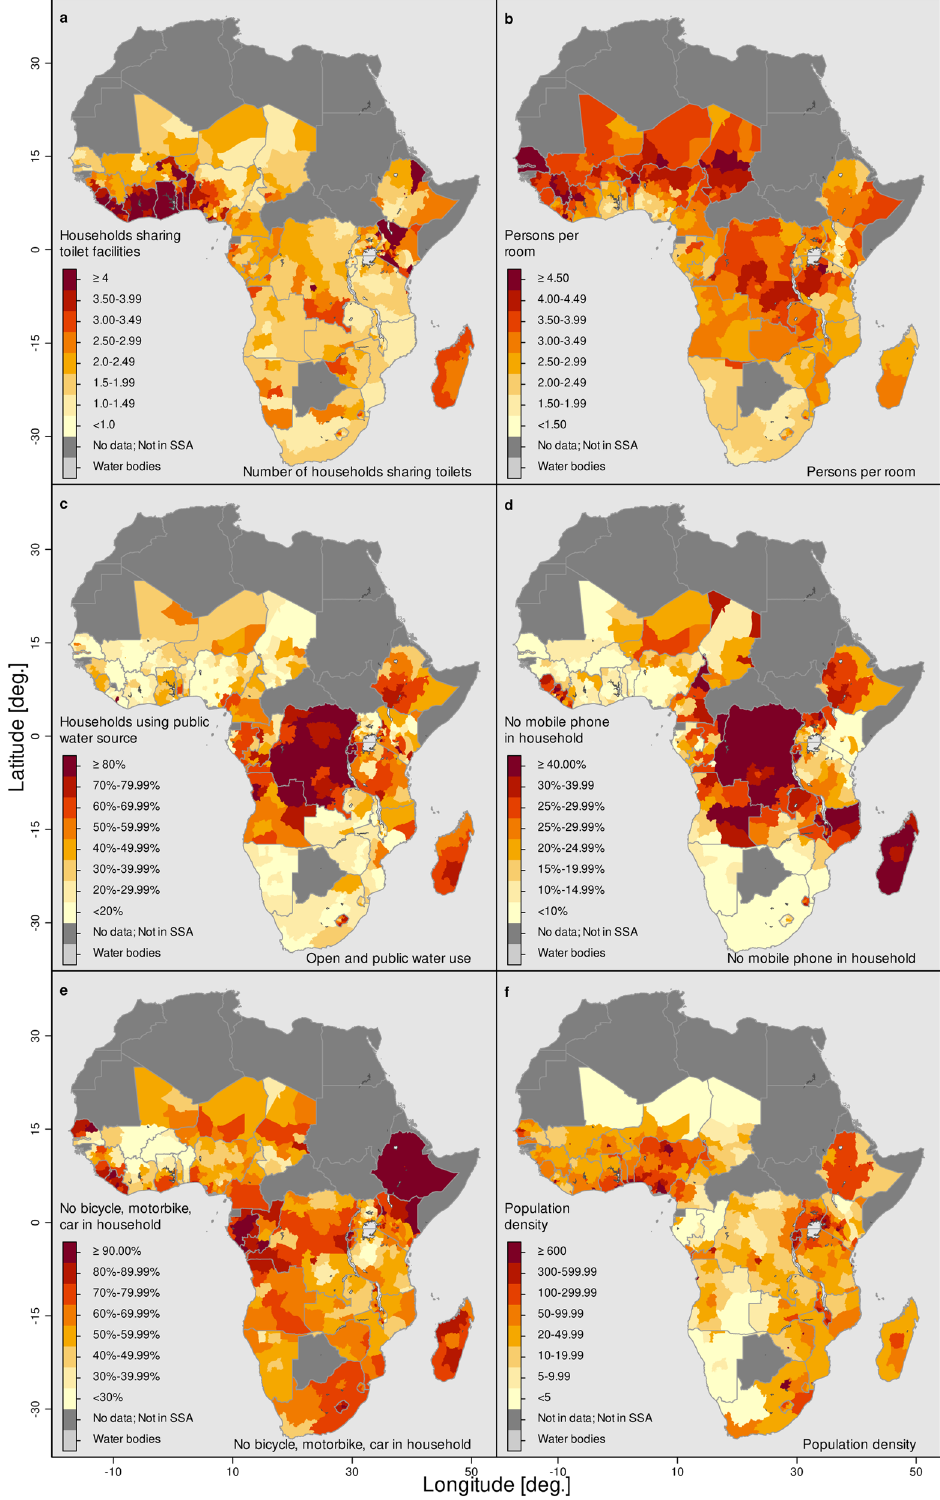
Fig. 4 Indicators of the PDI and population density at the regional level. The fi gure shows the shares at the regional level from top left to bottom right: ( a ) number of households sharing sanitation facilities, ( b ) number of people per room, ( c ) share of households using open and public water sources, ( d ) share of households without a mobile phone, e share of households with no bike, car or motorbike, and ( f ) population density (people per km 2 ) estimates for 2020. Source: DHS, and Center for International Earth Science Information Network — CIESIN — Columbia University 52 ; calculations by the